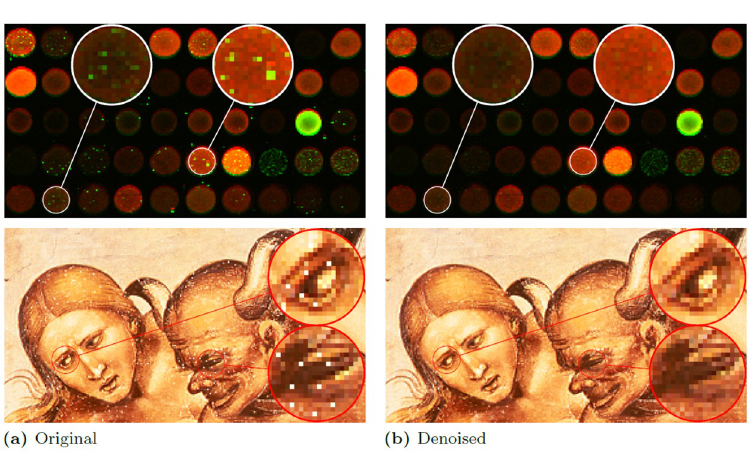
Fig 6. Impulse suppression performance on naturally corrupted images. Image of cDNA (a) and part of an image of the fresco “The Condemned in Hell” by Luca Signorelli (b) are presented.